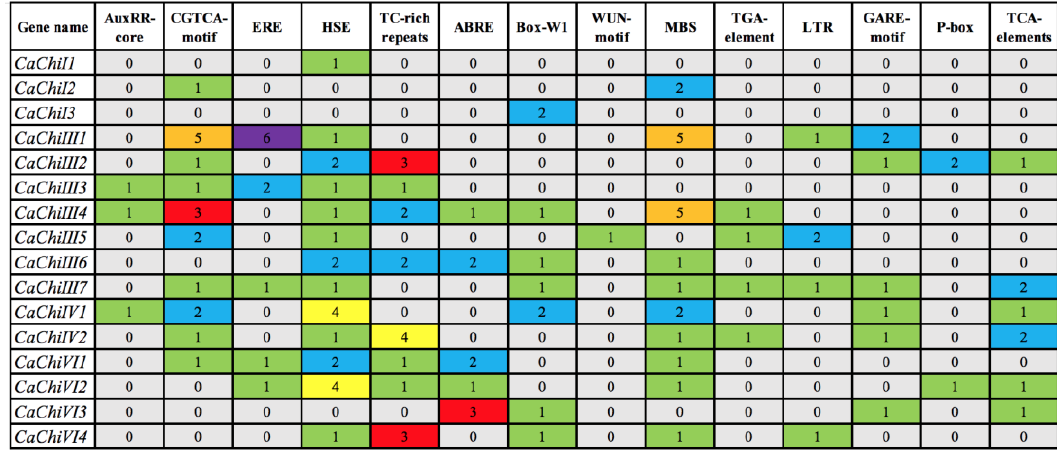
Figure 4. Chromosomal localization of CaChi of pepper plant, where the red shading box represents the tandem duplicated region. While the red, green and blue lines connection displaying segmentally duplicated genes.